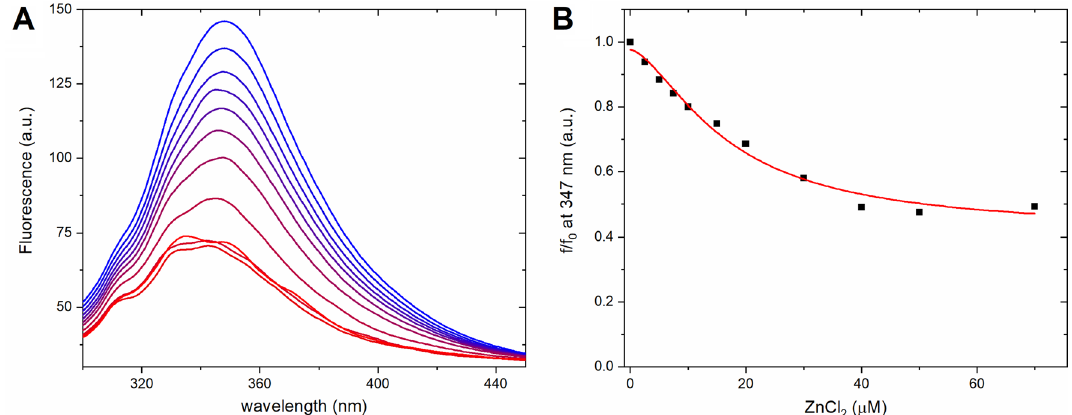
Figure 3. (A) Fluorescence spectra (excitation wavelength = 280 nm) of 0.5 μM hu PrP C protein titrated with 0 to 70 µM ZnCl 2 , see (B) , in 10 mM sodium phosphate buffer, pH 7.4 at 25 °C. The initial spectrum is in blue and the final in red. (B) Changes in the relative fluorescence intensity at 347 nm, fitted to Eq. (2) (K d = 16.8 ± 0.9